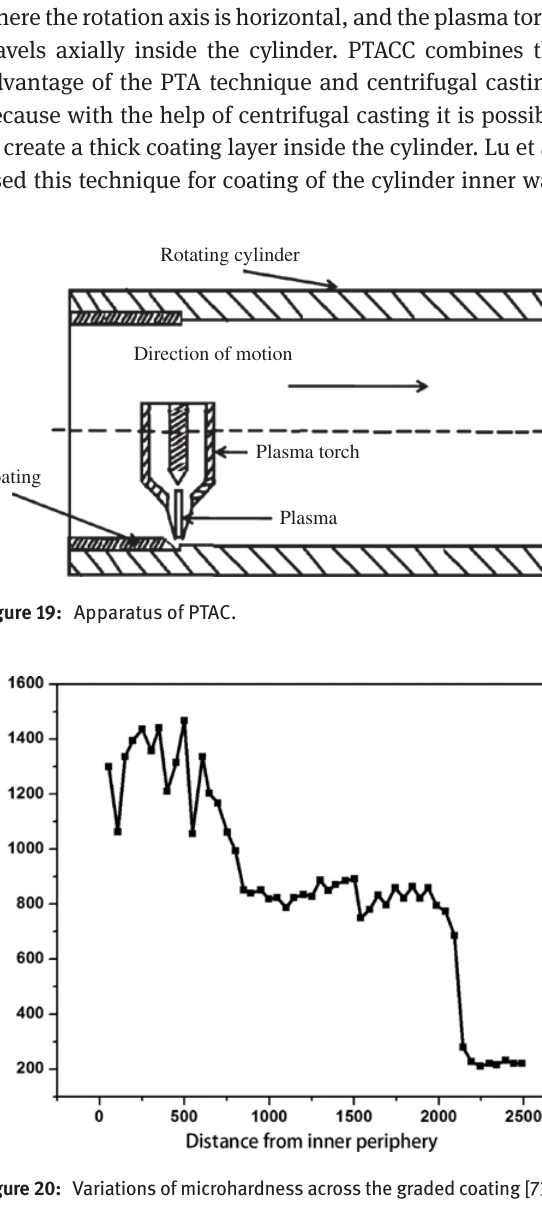
Figure 20: Variations of microhardness across the graded coating